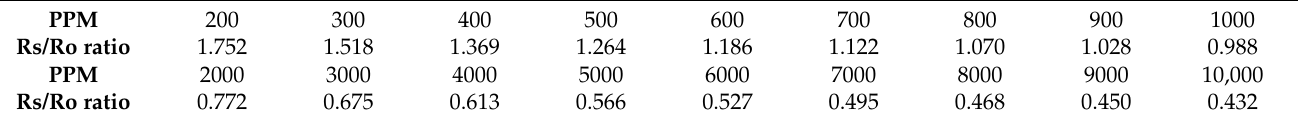
Table 7. Rs/Ro and concentration values of CH 4 from the MQ4 sensor